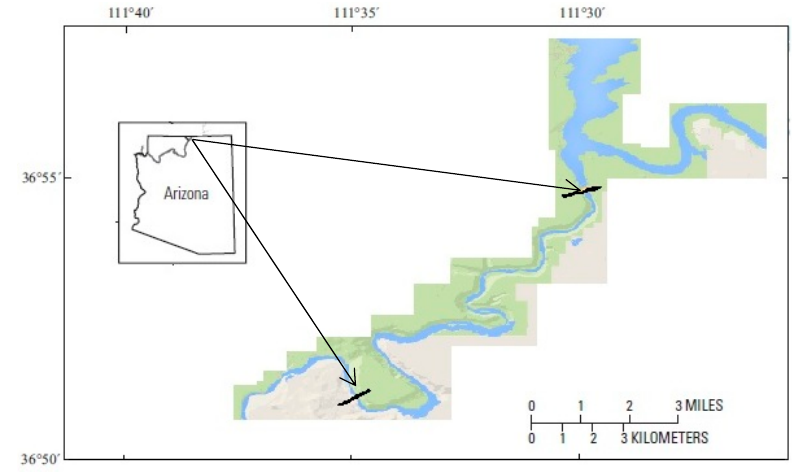
Figure 2. Photogrammetric base map of the study site of the Colorado River, which extends from Glen Canyon Dam to the Lees Ferry.